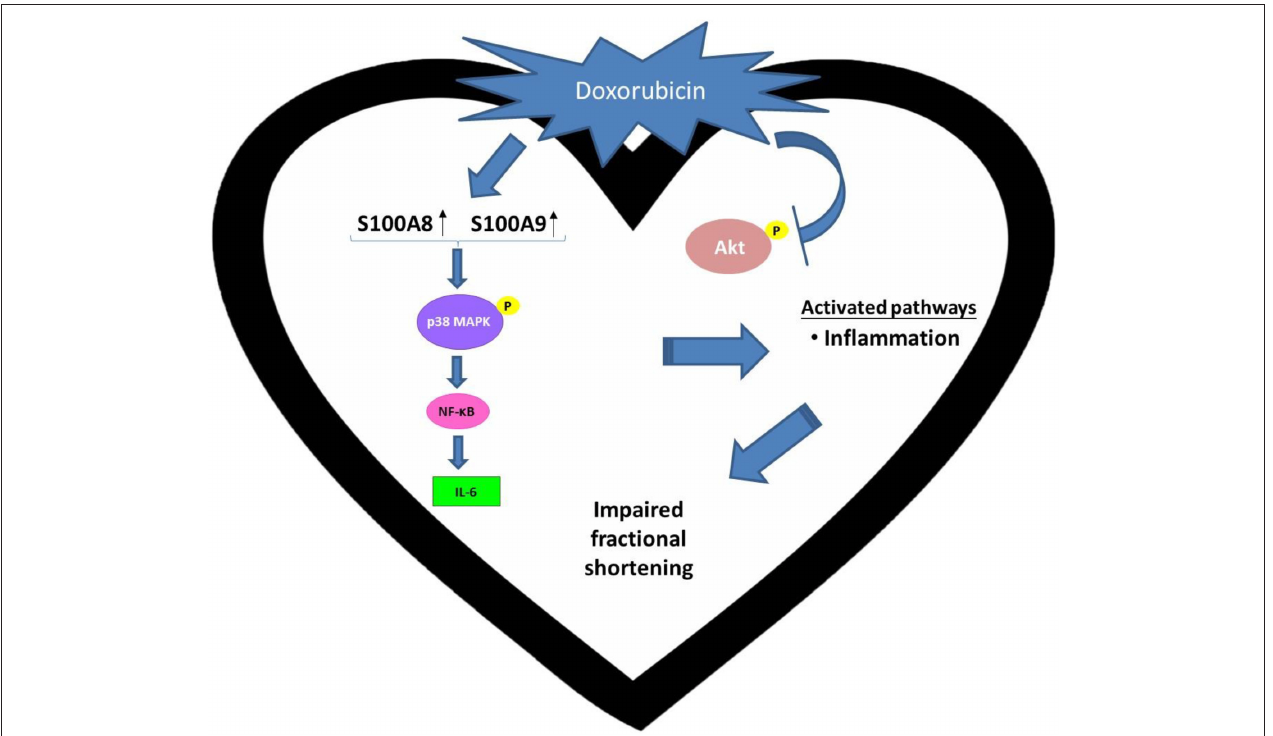
FIGURE 7 | Distinct mechanism of doxorubicin-induced toxicity in diabetic hearts. Doxorubicin (DOX) up-regulates S100A8/A9 and increases the expression of IL-6, which is a pro-inflammatory cytokine, in the diabetic heart through the p38 MAPK/NF- κ B axis. It is noteworthy that these observations were not made with non-diabetic hearts subject to DOX